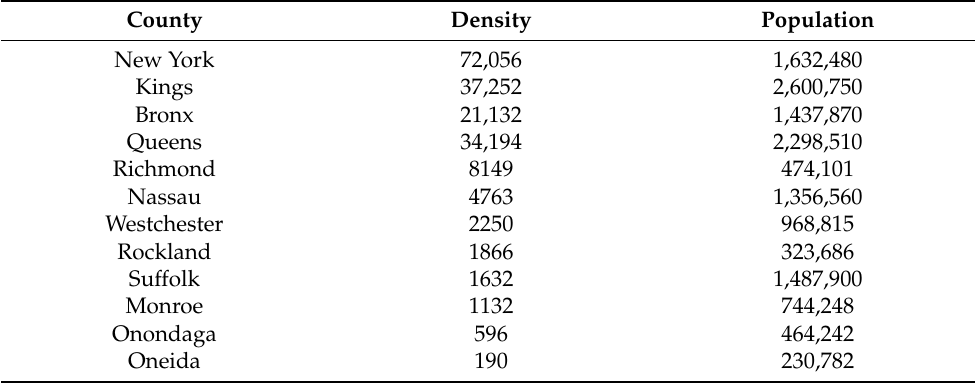
Table 1. Population density of the twelve investigated